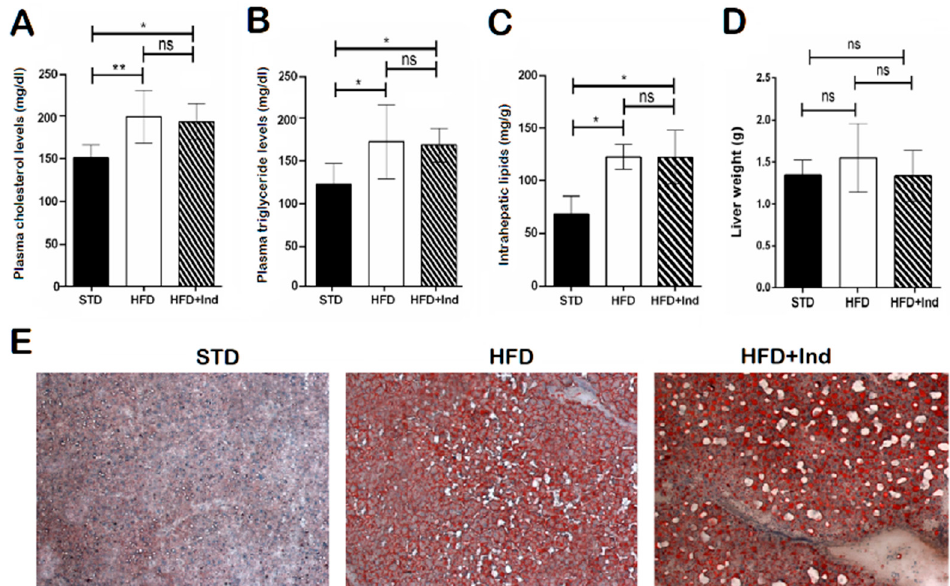
Figure 4. Impact of indicaxanthin treatment on lipid disorders in HFD mice. Plasma cholesterol levels ( A ), plasma triglyceride levels ( B ), intrahepatic lipid levels ( C ), liver weight ( D ), Oil Red O staining of liver sections ( E ) in the different animal groups. Results are shown as means ± SEM of 8 animals/group. ns: p > 0.05; * p ≤ 0.05; ** p ≤ 0.01 (ANOVA associated with Bonferroni’s correction).